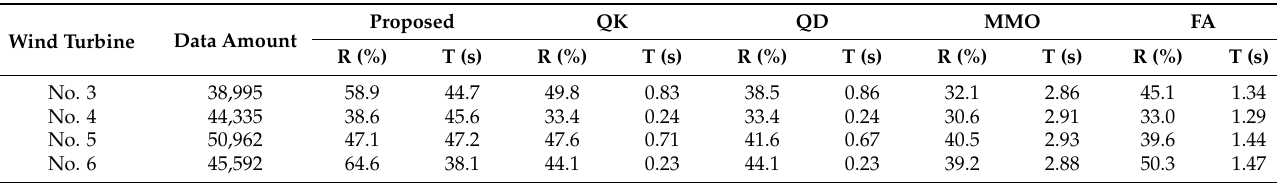
Table 1. Experimental results of five